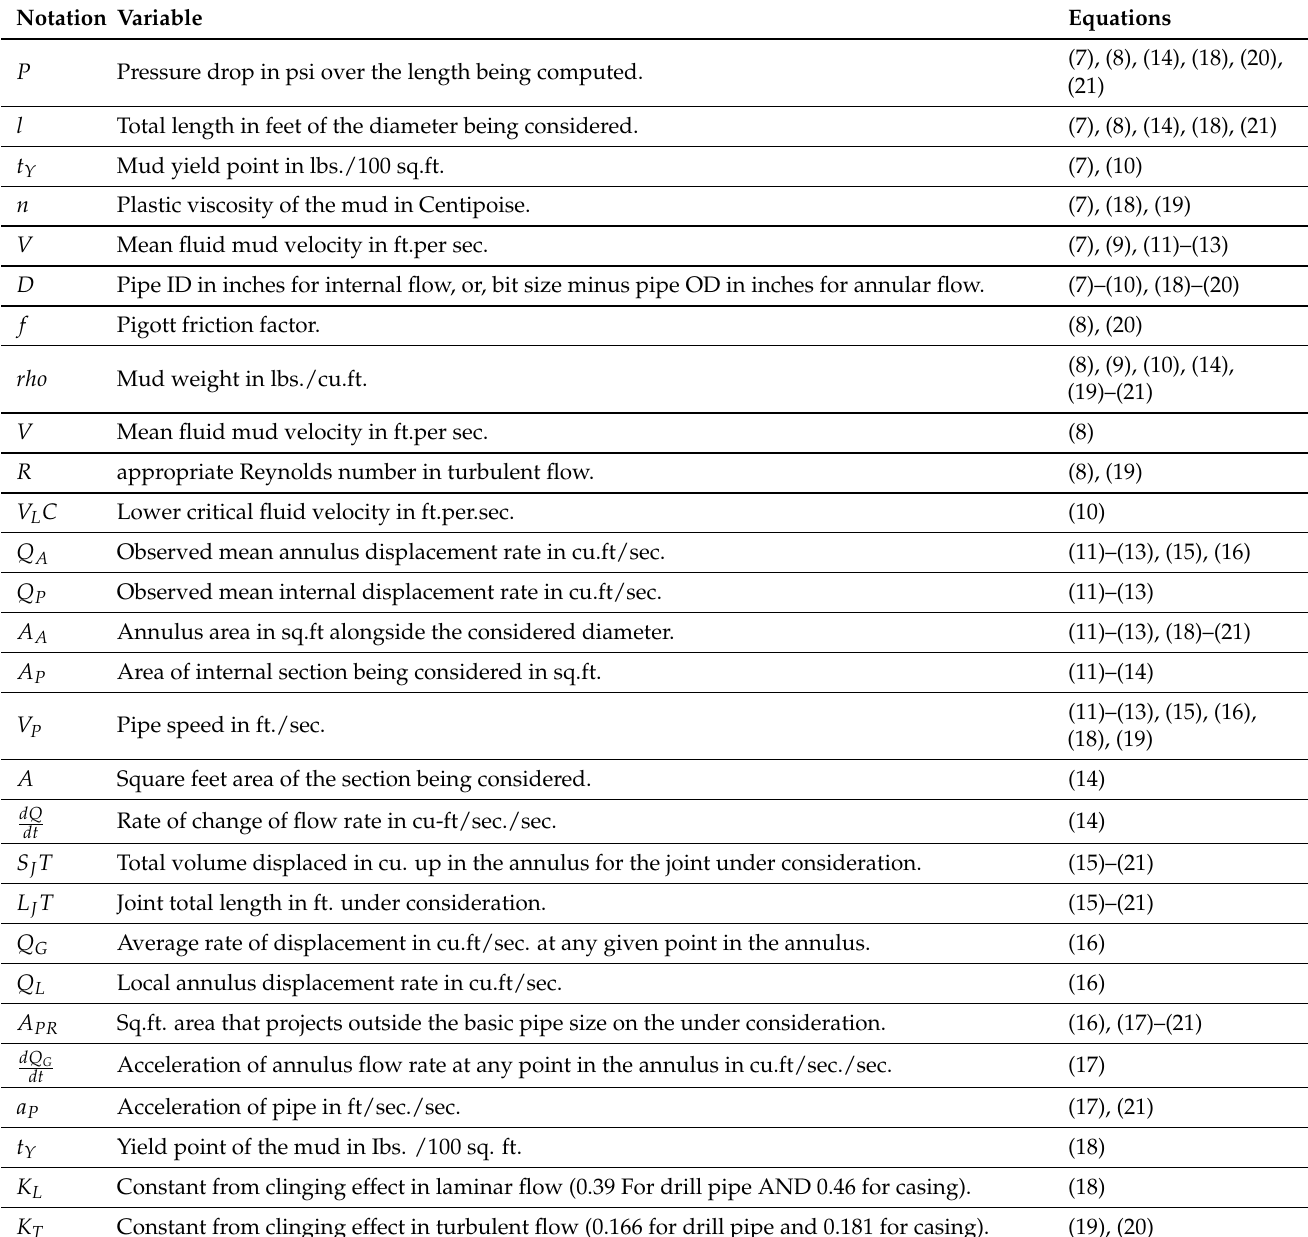
Table 1. The variables used in the model by Clark